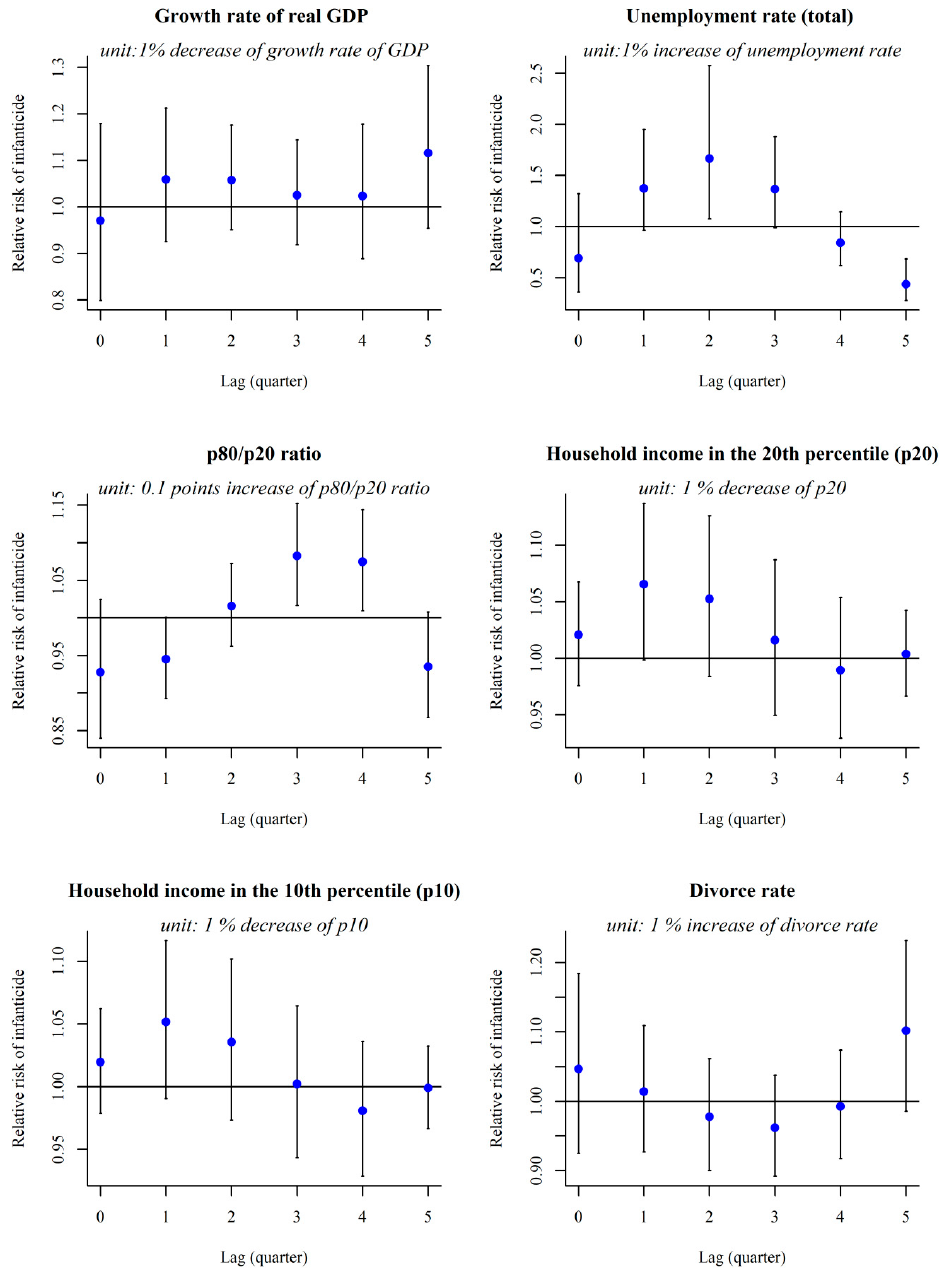
Figure 3. Time-lag effect of changes in socio-economic values on infanticide rate.